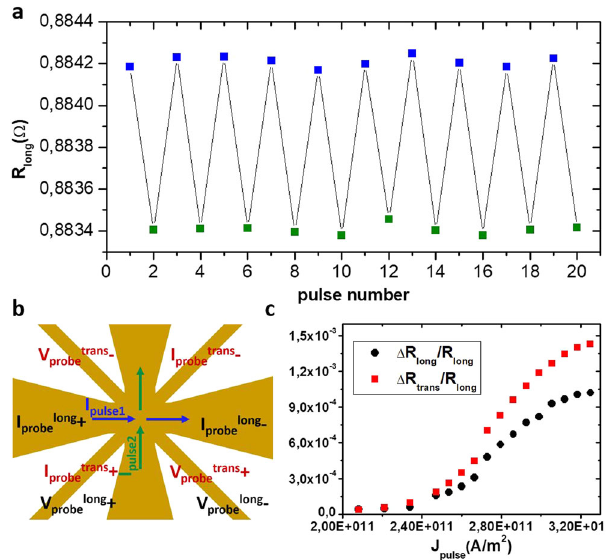
Fig. 4 | Switching induced anisotropic magnetoresistance. a Shows the alter- nating longitudinal resistance of a Mn 2 Au thin fi lm patterned in the geometry shownin b .Thelongitudinalresistancewasmeasuredaftereach1mscurrentpulse with J pulse =3×10 11 A/m 2 appliedalternatelyinperpendiculardirectionsasindicated by the blue and green arrows in b . The color of the data points corresponds to the arrows indicating the current direction. c Shows the dependence of the long- itudinal Δ R long as well as of the transverse Δ R trans resistance changes on the pulse current density J pulse